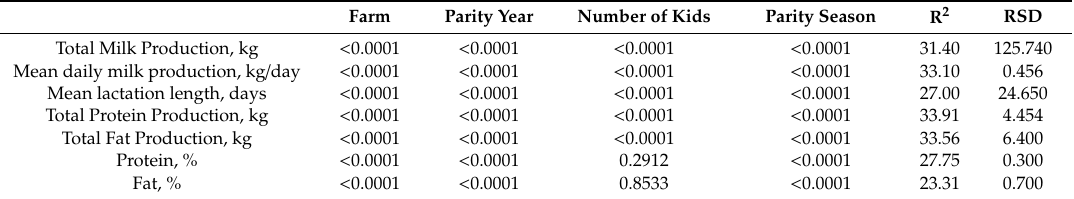
Table 3. Significance level ( p -value) for the farm, parity year and season and number of kid factors, determination coe ffi cient (R 2 ) and residual standard deviation (RSD) for the variables considered in the